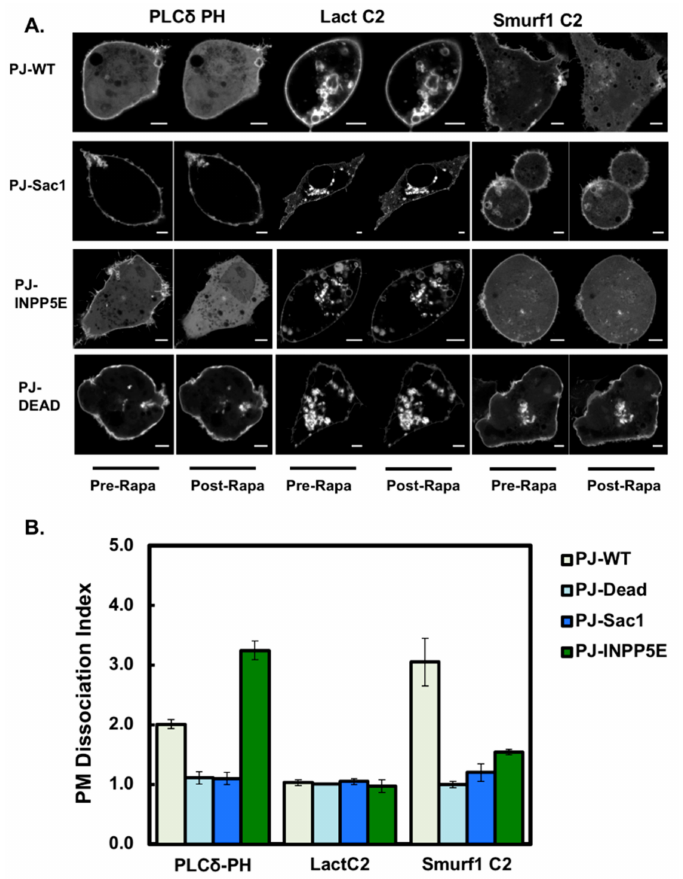
Figure 6. Rapamycin-recruited phosphatases knock down plasma membrane phosphoinositides to induce the de-localization of Smurf1 C2. ( A ) Images of controls (PLC δ -PH-GFP and Lact C2-mCherry) in addition to Smurf1 C2-GFP were taken before and 5 min after the addition of rapamycin. ( B ) Quantification of PIP depletion presented as dissociation indices (ratio of I PM / I cyto before and after treatment) for PLC δ -PH, lactadherin C2, and Smurf1 C2 (data are means ± SEM, n ≥ 4 di ff erent cells). The wild-type pseudojanin construct (PJ-WT) is compared to PJ-DEAD, PJ-Sac1, and PJ-INPP5E activity. These results show that Smurf1 is displaced following PIP depletion, showing that it binds to PIP at the plasma membrane. Scale bars = 5 µ